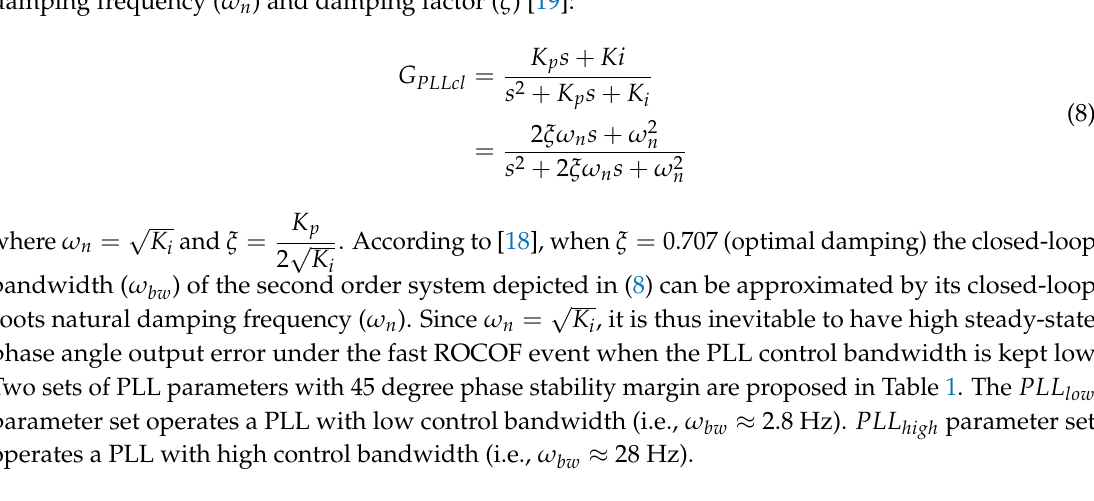
Table 1. PLL Parameters Selected for the